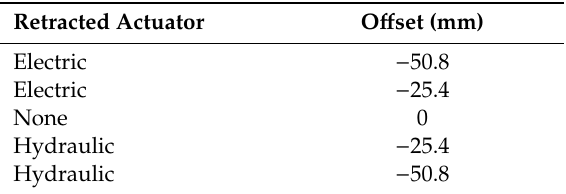
Table 2. Initial o ff set conditions for tandem function evaluation with one actuator set to an initial stroke of 203.2